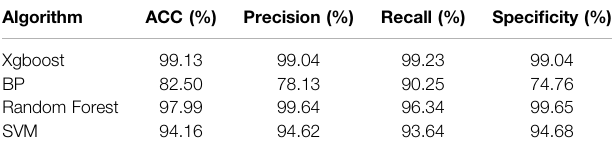
best. Besides, Xgboost uses the least time to build up the model. Figure 3 is the ROC curve of four methods. The red line is the curve of Xgboost. The green line is the curve of RF. The blue and black one is the SVM and BP respectively. As we can see in the fi gure, Xgboost is the best among these four methods. Then we draw a fi gure of AUC in the Figure 4 .